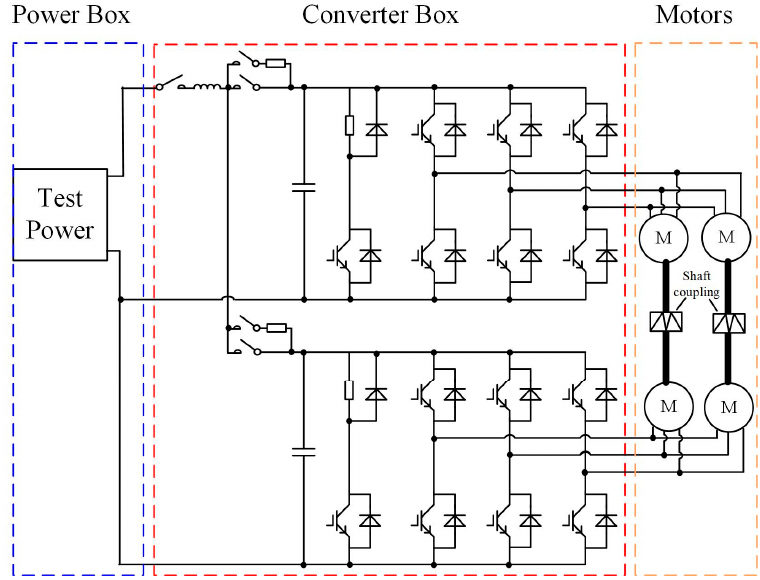
Figure 20. The back-to-back towing test platform topology. Table 7. Parameters of the experiment platform